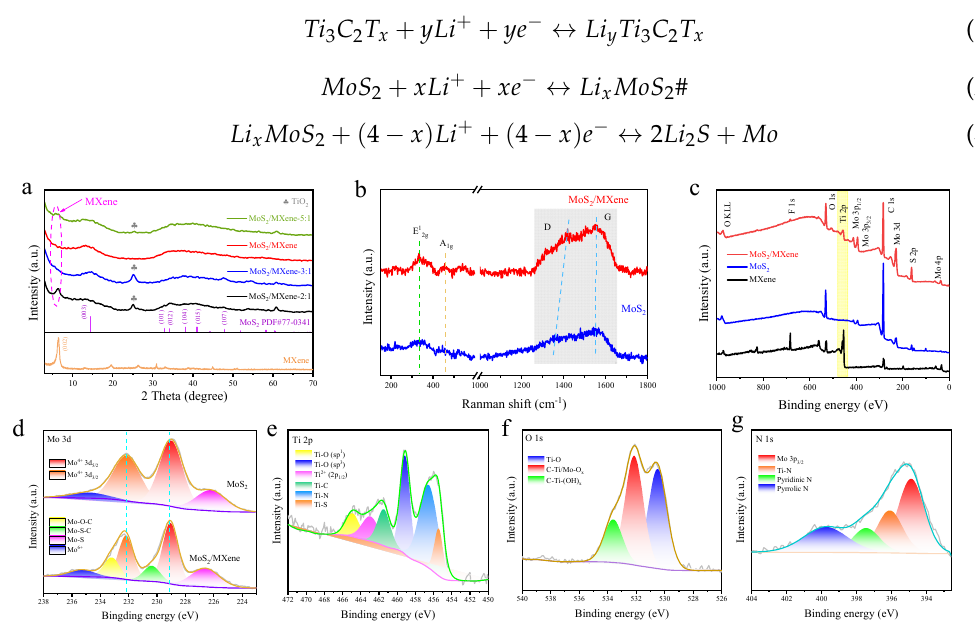
Figure 2. ( a ) XRD patterns of MoS 2 /MXene − x:1 (x = 2, 3, 4, 5) and MXene; ( b ) Raman spectra of MoS 2 /MXene composites and MoS 2 ; ( c ) XPS full spectra of MoS 2 /MXene, MoS 2 and MXene; high-resolution ( d ) Mo 3d XPS spectra of MoS 2 and MoS 2 /MXene; high-resolution ( e ) Ti 2p ( f ) O 1s and ( g ) N 1s XPS spectra of MoS 2 /MXene. The electrochemical performance was evaluated by a half-cell system. Figure 3a il- lustrates the CV curves of MoS 2 /MXene in the first three cycles at 0.1 mV s − 1 scanning rate and in a voltage range of 0.01 to 3.0 V (vs. Li + /Li) for the study of the lithium ion lithia- tion/de-lithiation behavior. Within the initial cathodic scan curve, the peaks at 0.5–1.0 V are attributed to the formation of Li x MoS 2 in the Li + intercalated into the MoS 2 and Li + intercalated into the MXene interlayer to form Li y Ti 3 C 2 T x , along with the generation of solid electrolyte interphase (SEI) film, and the peak at around 1.9 V is probably attributed to the reduction of Li x MoS 2 to Mo and Li 2 S. The reduction peak at 0.01 V is attributed to